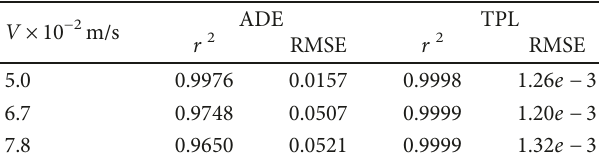
Figure 8: Comparison of ADE and TPL when v = 7 8 × 10 − 2 m/s : (a) normal coordinate system; (b) semilog scale coordinate system. Table 3: The fi tting parameters of BTCs at three